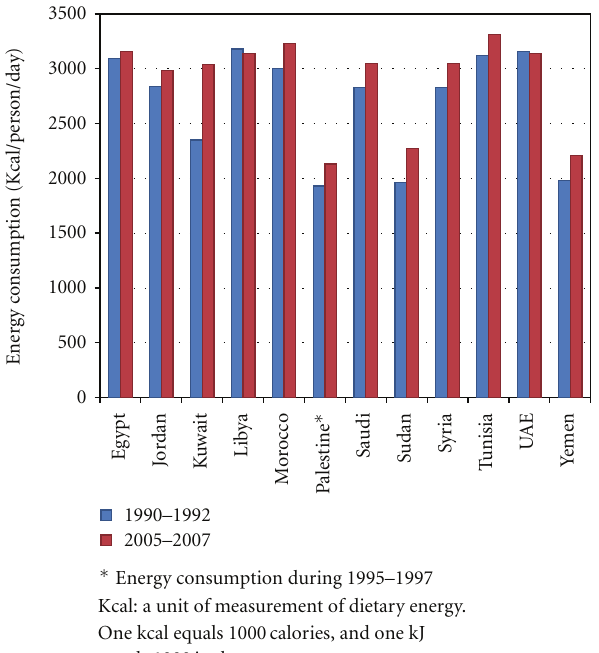
Figure 2: The dietary energy consumption per person, in kcal per day, according to the Food and Agriculture Organization of the United Nations (Statistics Division 2010, Food Balance Sheets ).